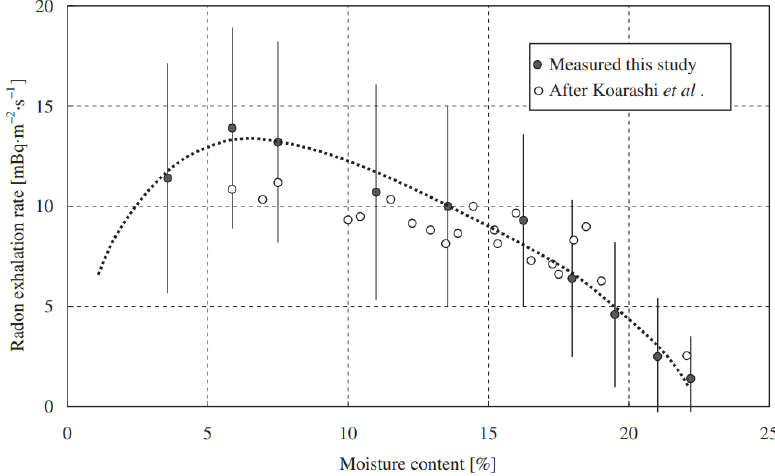
Figure 1. Radon flux from soil as a function of soil moisture content (taken from [129]) .